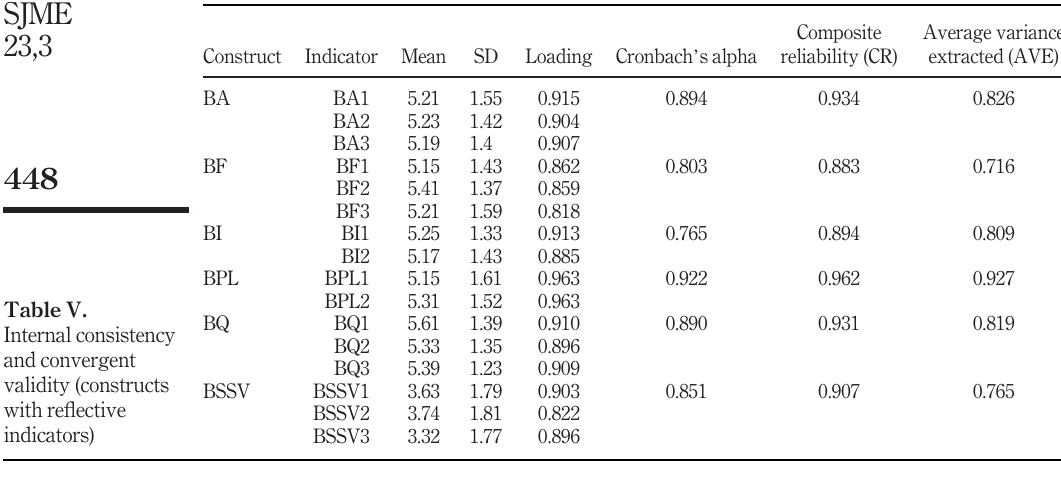
Table VI. Discriminant validity: fi rst-order latent variables correlations and square root of the average variances extracted (Fornell –